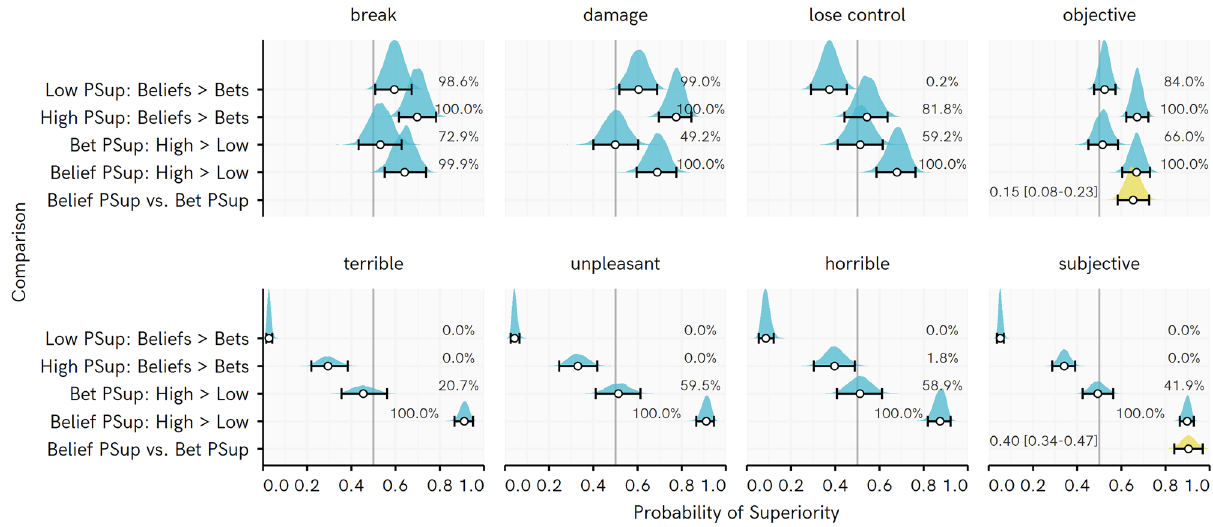
Figure 2. Posterior distribution of regression-based probability of superiority (PSup) estimates for Experiment 1. Percentages indicate the proportion of the posterior PSup estimate > 0.5 (e.g., for Beliefs: High—Low, 100% of the posterior for every belief is over 0.5, indicating consistently higher belief rating among high than low fear participants). Points represent posterior median, whiskers represent 95% HDI, ridge height reflects density of estimate. Belief PSup vs. Bet PSup = difference in PSup estimates for Beliefs: High > Low vs. Bets: High > Low, with values above 0 indicating a greater difference between High and Low fear participants in Beliefs than Bets, with posterior median and [95% highest density interval]. Note that position of this density ridge on the X axis has been shifted by 0.5 so that the line at 0.5 represents 0 for this posterior